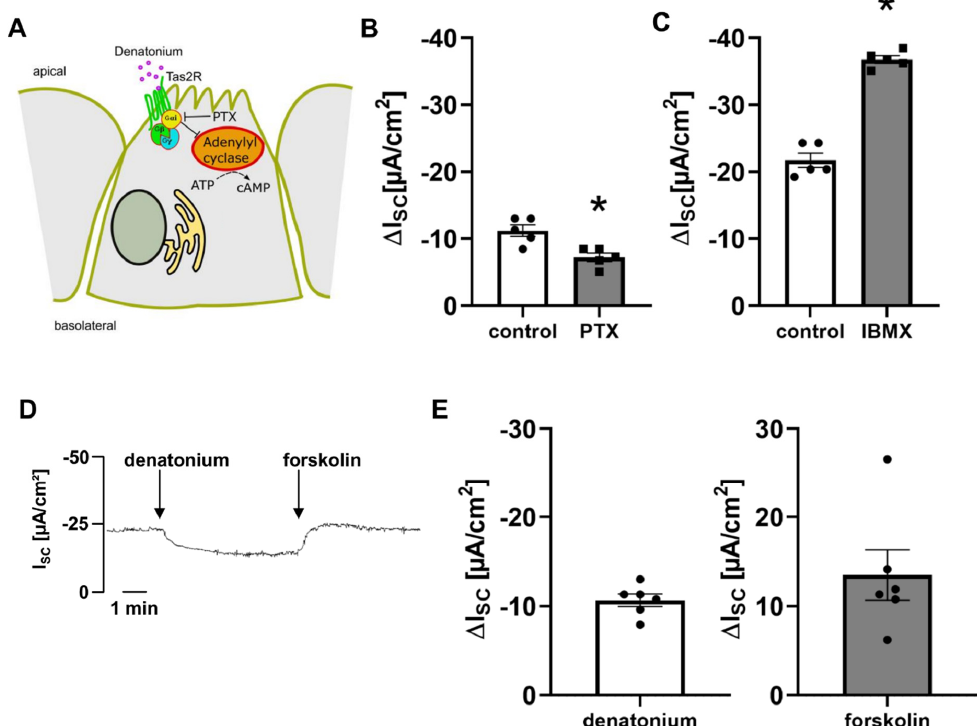
Figure 7. Denatonium influences cAMP-dependent ion currents. ( A ) Schematic drawing of the effect of pertussis toxin (PTX). ( B ) The inhibitor of the G α i subunit pertussis toxin (500 ng/mL, apical) reduced the denatonium-induced current ( ∆ I SC , n = 5, * p < 0.05). ( C ) In the presence of the phosphodiesterase inhibitor IBMX (100 µ M apical), the denatonium-induced effect was increased ( ∆ I SC , n = 5, * p < 0.05). ( D ) Apical application of 1 mM denatonium decreased I SC , which was reversed by forskolin (50 µ M, apical). Representative current trace. ( E ) Forskolin increased I SC in the presence of denatonium by approximately the same extent as it was decreased before with denatonium ( ∆ I SC , n =